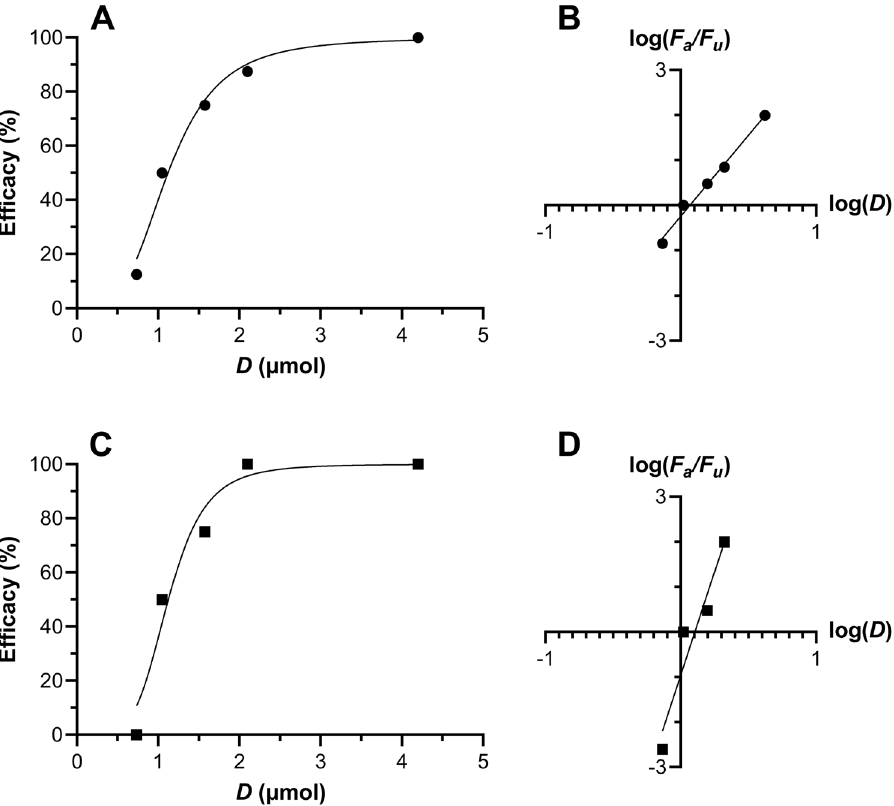
Figure 14. Dose–response curves for vaginal ( A , B , circles) and rectal ( C , D , squares) HIV-1 challenge studies in humanized BLT mice following oral TAF administration. Plots of ( A ) vaginal and ( C ) rectal efficacy versus dose of oral TAF ( N = 8 per dosing group, 5 groups) administered 6 h prior to HIV-1 challenge. Solid lines are fits to a sigmoidal dose-normalized response (variable slope) model. Median-effect model analysis 59 using log–log dose–response relationships of ( B ) vaginal and ( D ) rectal efficacy as a function of oral TAF dose allows key pharmacodynamic parameters to be calculated, as summarized in Table 4 F a , fraction affected; F u , fraction unaffected; D , dose (µmol).